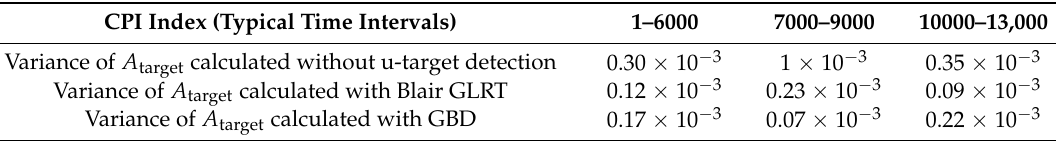
Table 2. Variance of target angle in typical time intervals.